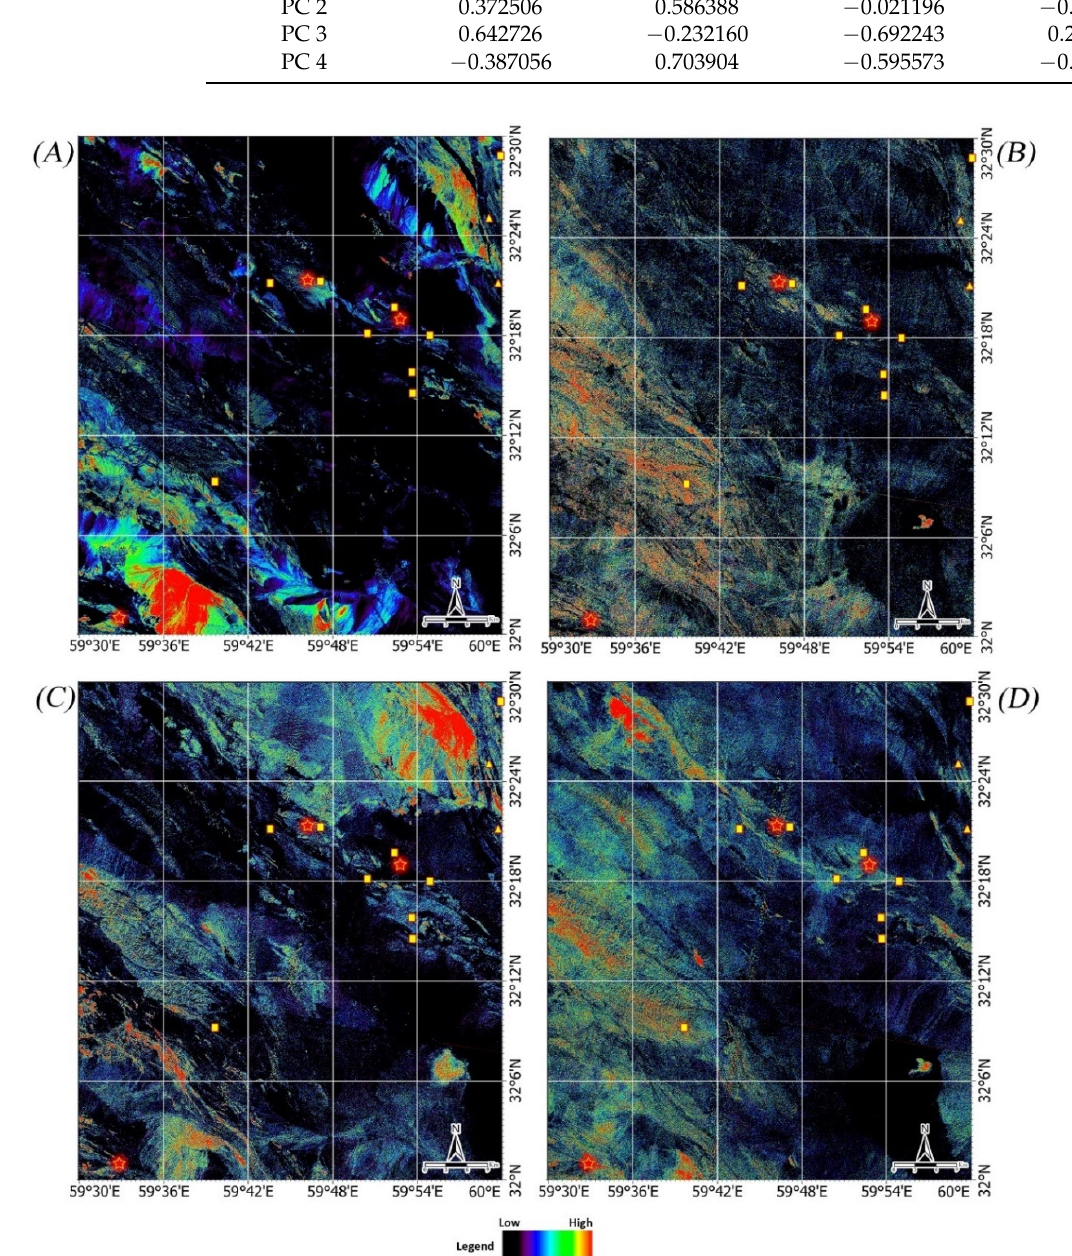
Figure 7. Pseudo-color ramp of SPCA results. ( A ) PC2 shows the surface distribution of iron ox- ide/hydroxides; ( B ) PC4 shows the surface distribution of argillic alteration; ( C ) PC4 shows the surface distribution of phyllic alteration; ( D ) PC4 shows the surface distribution of propylitic alteration.